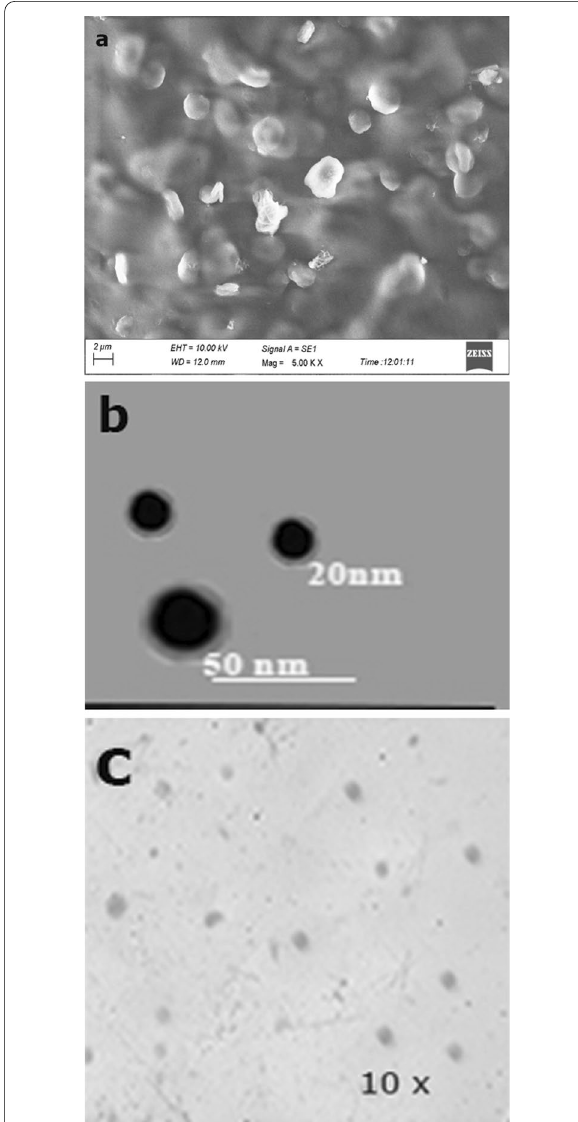
Fig. 7 a SEM, b TEM, c Optical microscopic images of optimized formulation